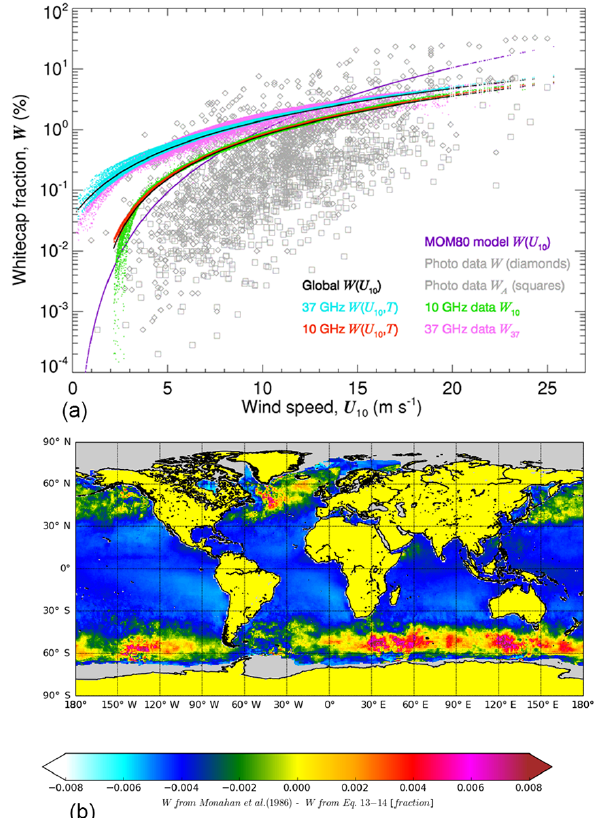
Figure 14. (a) In situ W data as in Fig. 1b (gray symbols) and satellite-based W data for 17 March 2007 at 10 and 37GHz (green and magenta symbols, respectively) compared to W values obtained from W(U 10 ) for 10 and 37GHz (black symbols, Eqs. 10–11) and W(U 10 ,T ) for 10 (red) and 37GHz (cyan, Eqs. 13–14). (b) Dif- ference map of annual average W distribution for 2006 calculated from the Monahan and O’Muircheartaigh (1980, MOM80) W(U 10 ) parameterization (Eq. 3) minus W(U 10 ,T ) from Eqs. (13)–(14). The calculations use wind speed U 10 and SST T from the white- cap